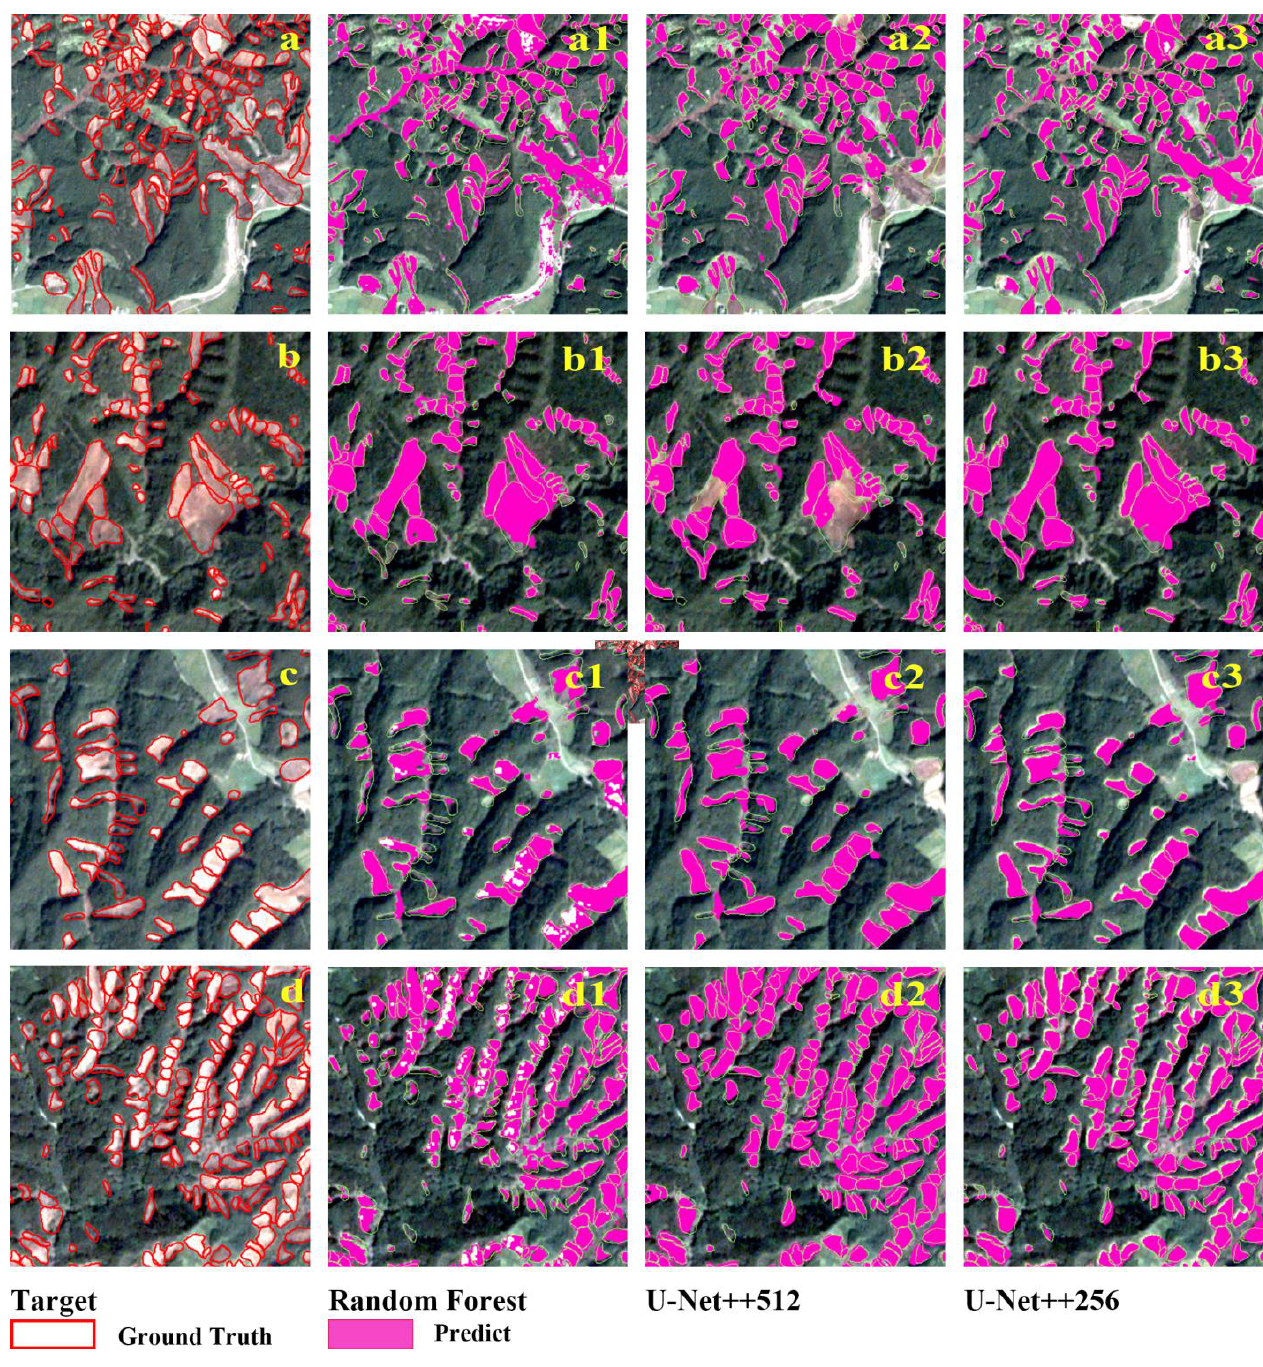
Figure 11. Comparison of results using different models. ( a – d ) Planet image with ground truth of landslides (red boundary polygons), identified landslides (peach polygons) by RF ( a1 – d1 ), U − Net++512 ( a2 – d2 ), and U − Net++256 ( a3 – d3